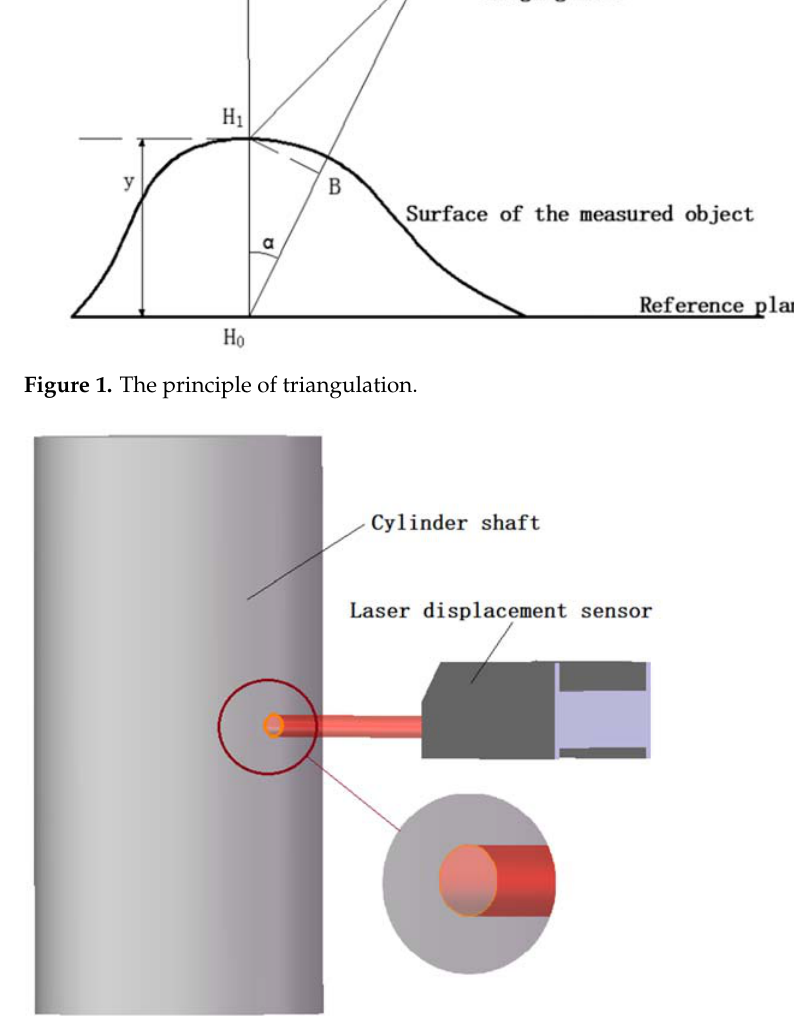
Figure 3. The spot shape when laser beam is off ‐ center. As shown in Figure 4,